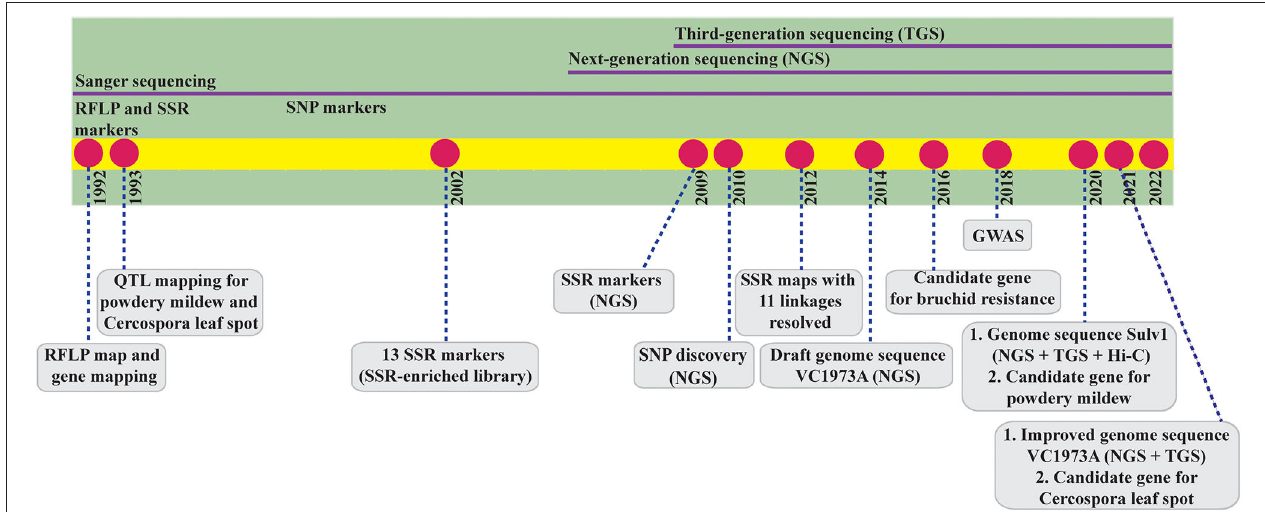
FIGURE 1 | Timeline of mungbean genome research since the first publication of genome mapping in 1992. RFLP, restriction fragment length polymorphism; QTL, quantitative trait locus; SSR, simple sequence repeat; SNP, single nucleotide polymorphism; GWAS, genome-wide association study; Hi-C, high-throughput chromosome conformation